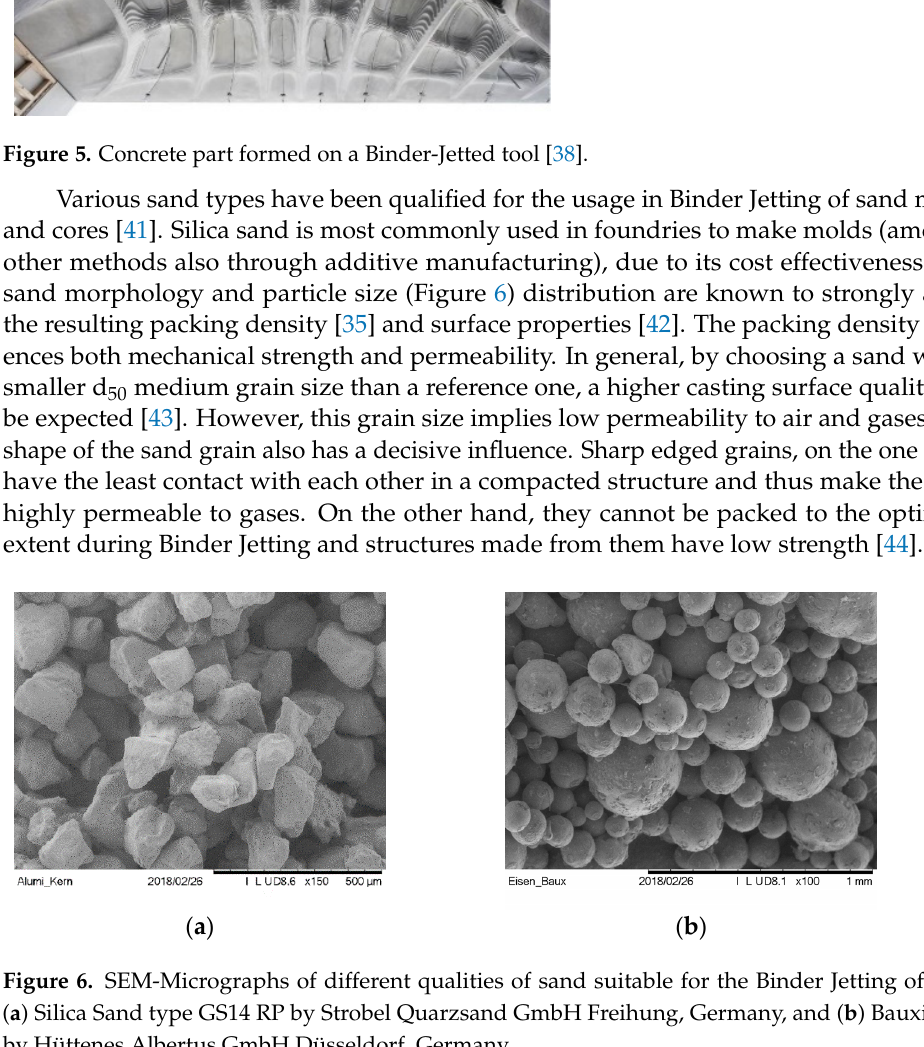
Figure 5. Concrete part formed on a Binder-Jetted tool [38].